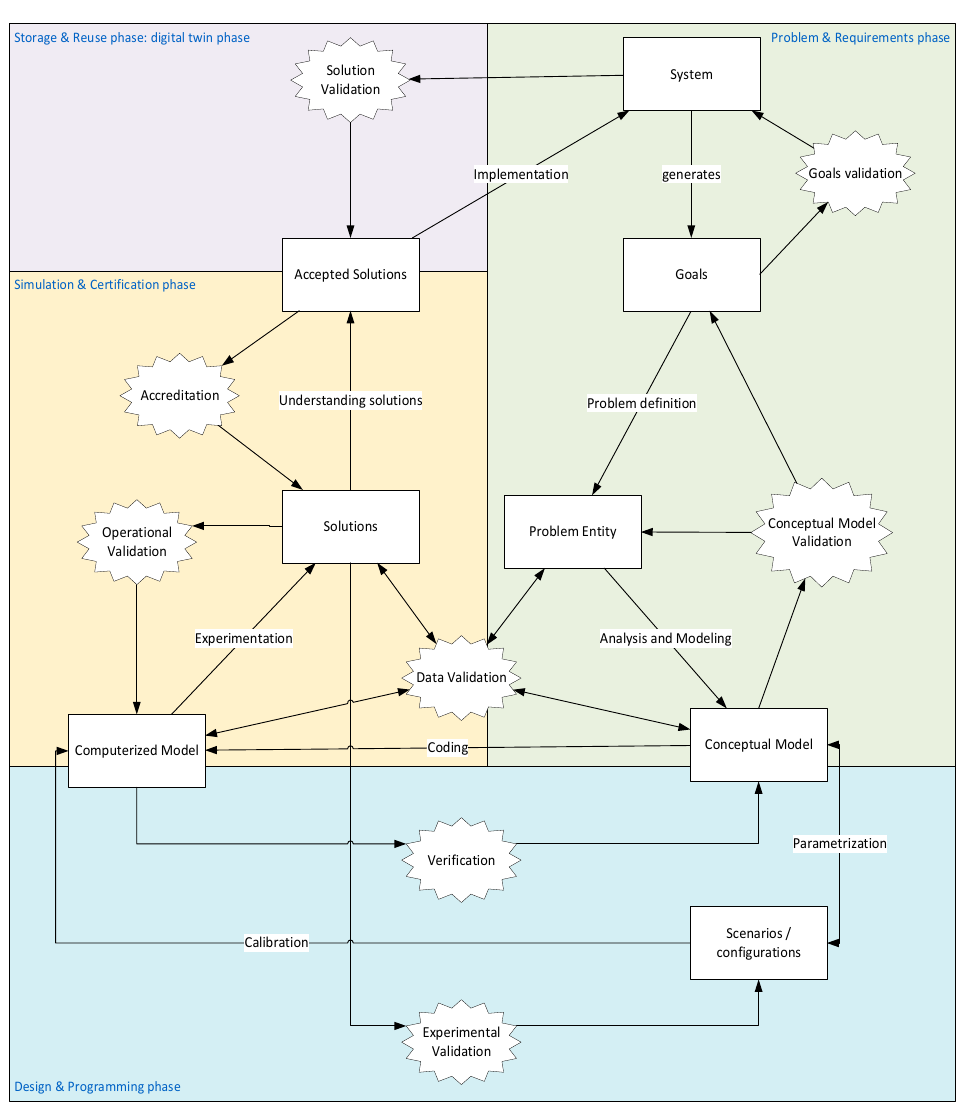
Figure 1. The proposed life cycle for a simulation project. The squares represent products, like the definition of the problem, the model coding, or the solutions obtained. The stars represent validation and verification actions that must be done to ensure the correctness of the products. If this process fails, we will come back to the previous product. In order to navigate from one product to another, an action must be done, like the coding to obtain the “Computerized Model” from the “Conceptual Model”. On the diagram, the cycle is mapped on the different phases proposed by [19]. In Figure 1, the various products that are going to be affected or created by the simulation project are represented in a square. There are eight of these: (i) the Goals , since the clarification of the relevant elements that rule the organization are a product by itself; (ii) the Problem Entity , which is the definition of the problem that we are going to analyze that is generated by the Goals of the organization; (iii) the Conceptual Model , that represents a complete and unambiguous representation of the model; (iv) the Scenarios/Configurations to be analyzed; (v) the Computerized Model , that is the simulator that codes the model; (vi) the Solutions , (vii) the Accepted Solutions , accepted because a model-based discussion, and the (viii) System itself since it will be modified based on the Accepted Solutions